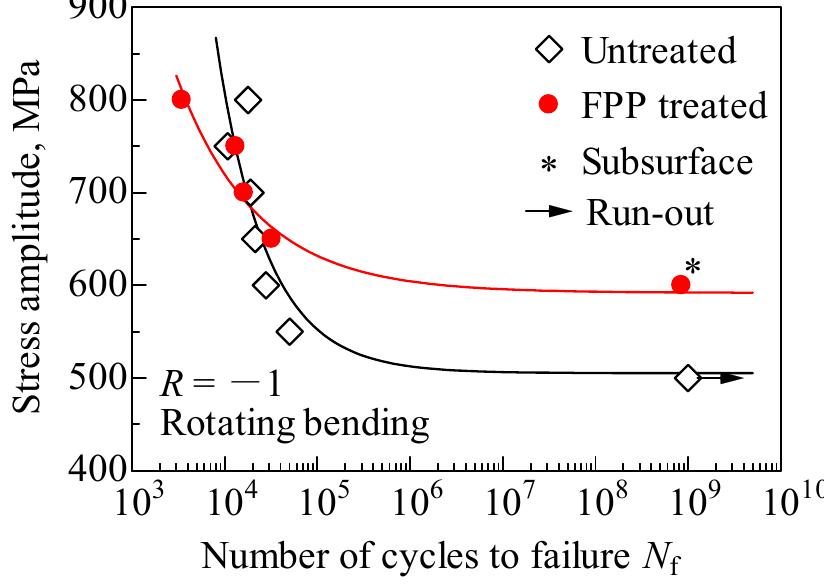
Figure 9. S–N diagram for untreated and FPP-treated specimens.